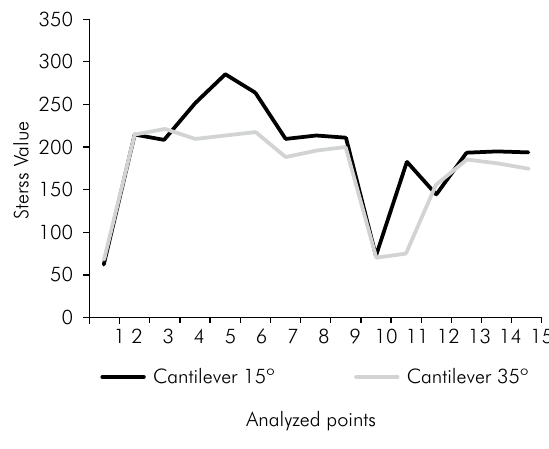
Graph 1. Stress behavior for points analyzed per group for load at the end of